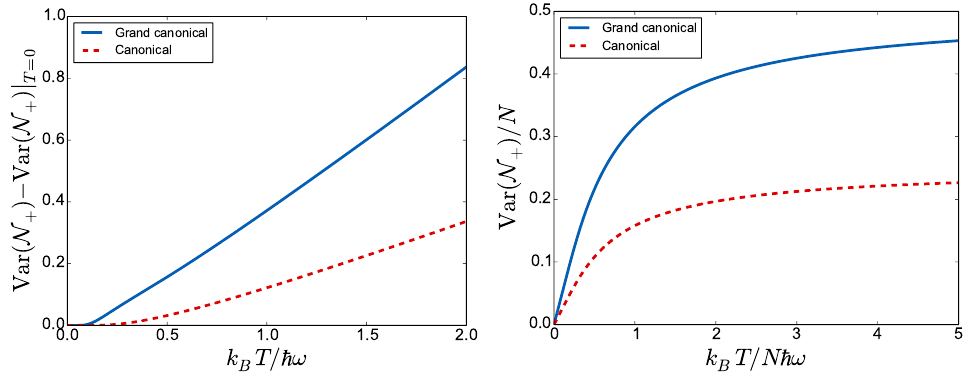
Figure 2: Variance of the number (cid:78) + of fermions in the domain x > 0 as a function of the temperature, both in the canonical and grand canonical ensembles. Left: quantum regime T ∼ T . Right: thermal regime T ∼ T . In the grand canonical case, the number of particles Q F g N must be replaced by its mean value N